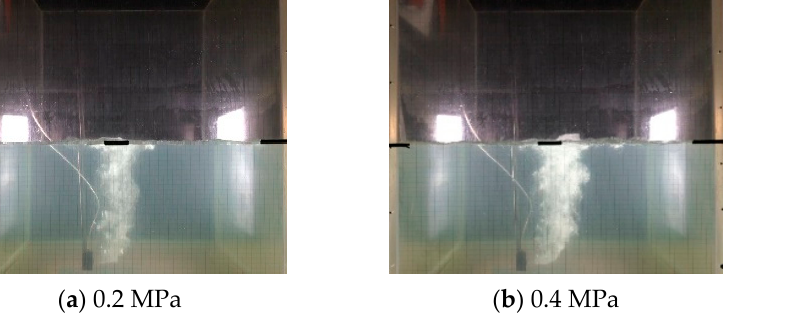
Figure 5. Images of underwater gas plumes under three leakage pressures.